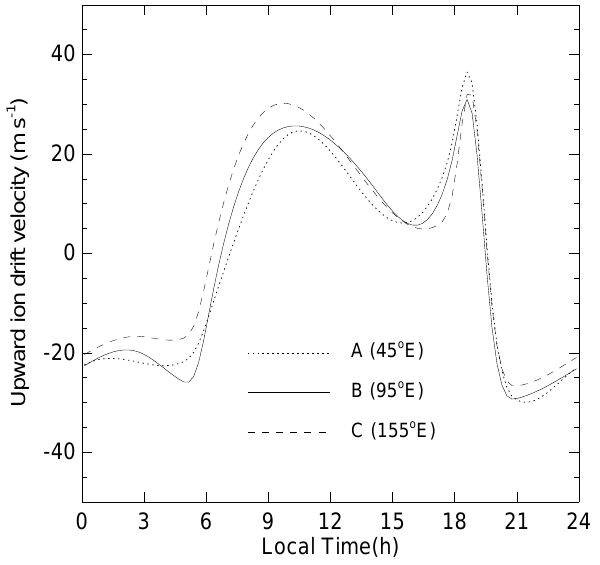
Fig. 2. The empirical SF model E × B drifts at 45 ◦ E (solid line), 95 ◦ E (dotted line), and 155 ◦ E (dashed line) on 26 March 2002.